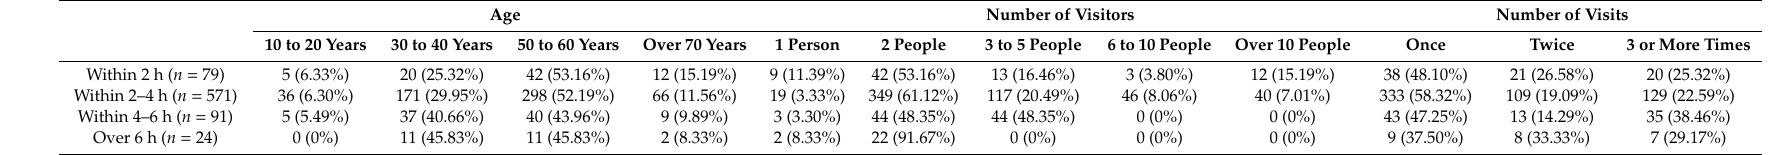
Table 3. Demographic characteristics of visitors with di ff erent durations of stay.